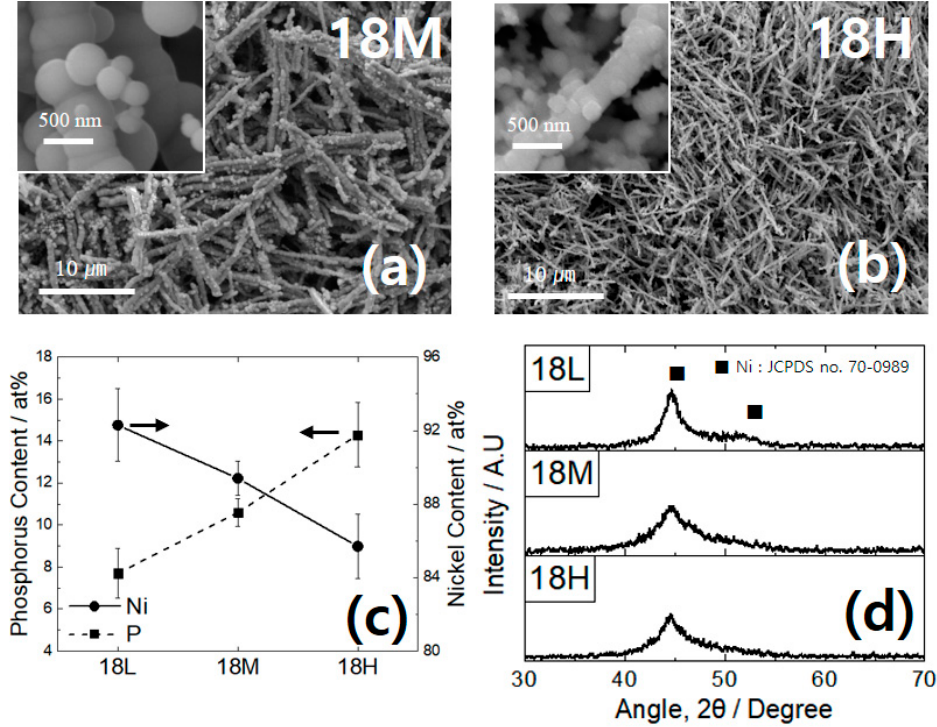
Figure 3. Scanning electron micrographs of the nickel phosphide nanowires prepared at different combinations of pH and reducing agent content: ( a ) sample 18M and ( b ) sample 18H in Table 1. Inset figures are the magnified images. ( c ) Phosphorus and nickel contents in the samples obtained from the EDS analysis and ( d ) their XRD patterns.